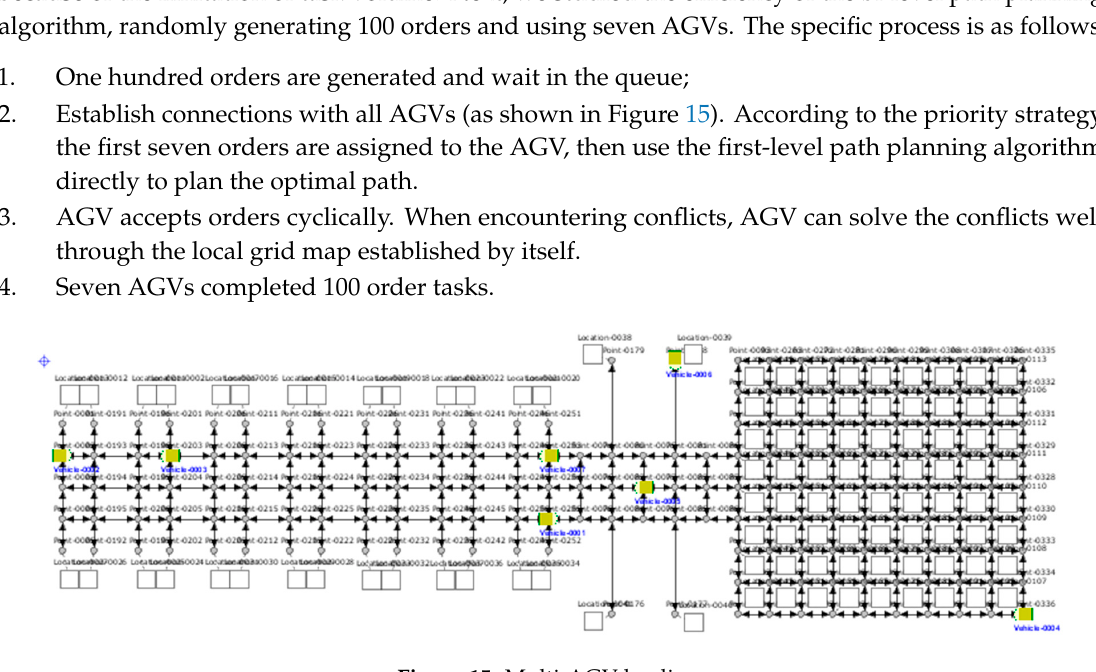
Figure 15. Multi-AGV loading.